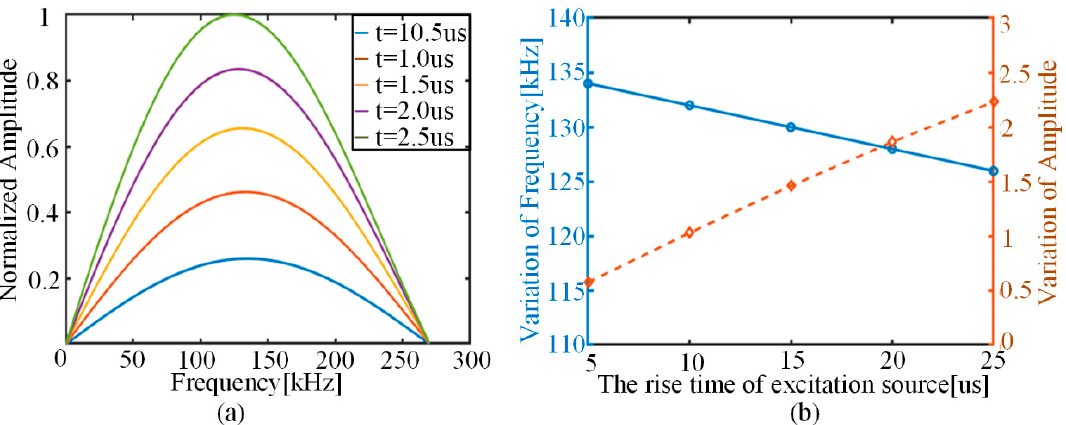
Figure 10. Variation in predicted AE results for different rise times: ( a ) change in model-predicted AE frequency spectrum; ( b ) trend of model-predicted main frequency and corresponding amplitude.